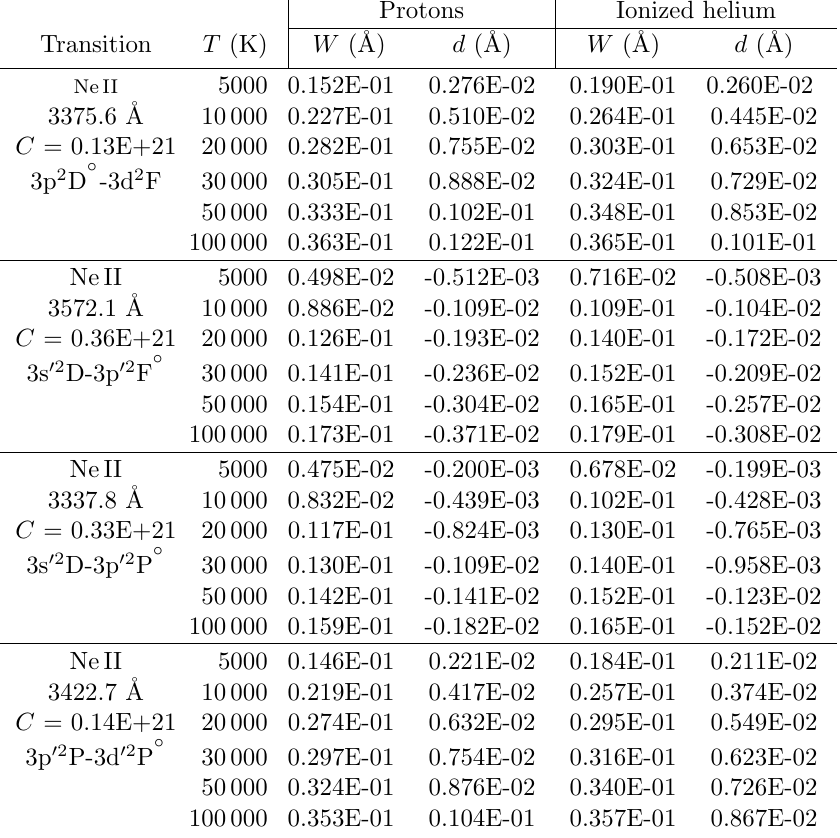
Table 2. Stark broadening parameters for Ne II multiplets for a perturber density of 10 17 cm − 3 . Designations are the same as in Table